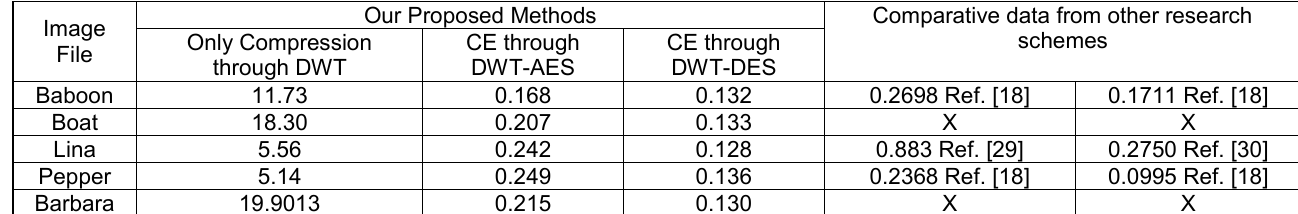
Table 4. Comparison of MSE for different Compression encryption techniques